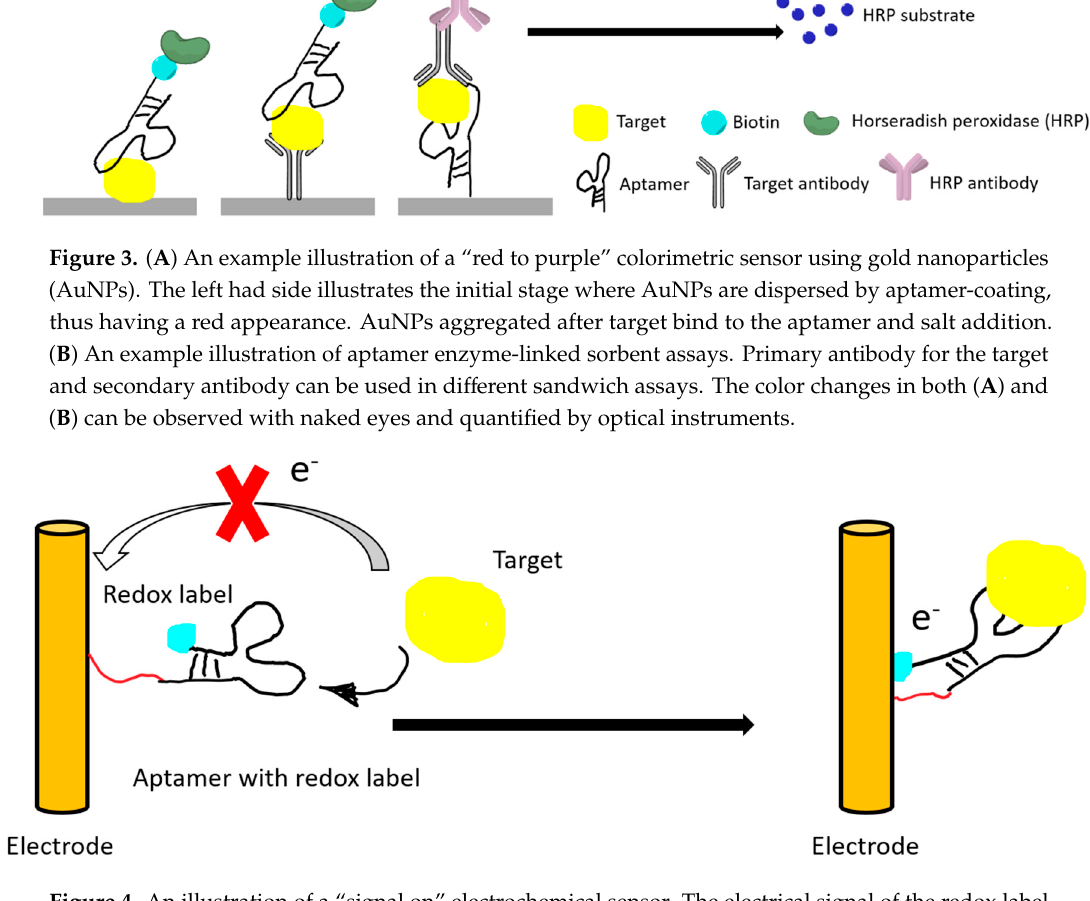
Figure 4. An illustration of a “signal on” electrochemical sensor. The electrical signal of the redox label is recorded after target binding and subsequent conformational change of the aptamer.